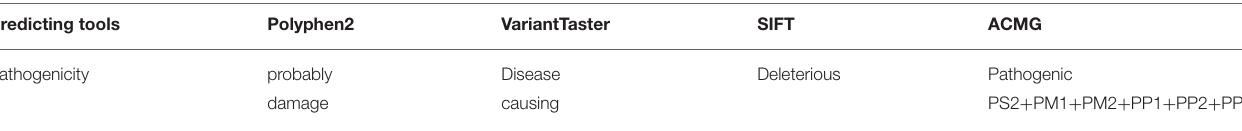
TABLE 1 | The pathogenicity prediction using different online tools. Predicting